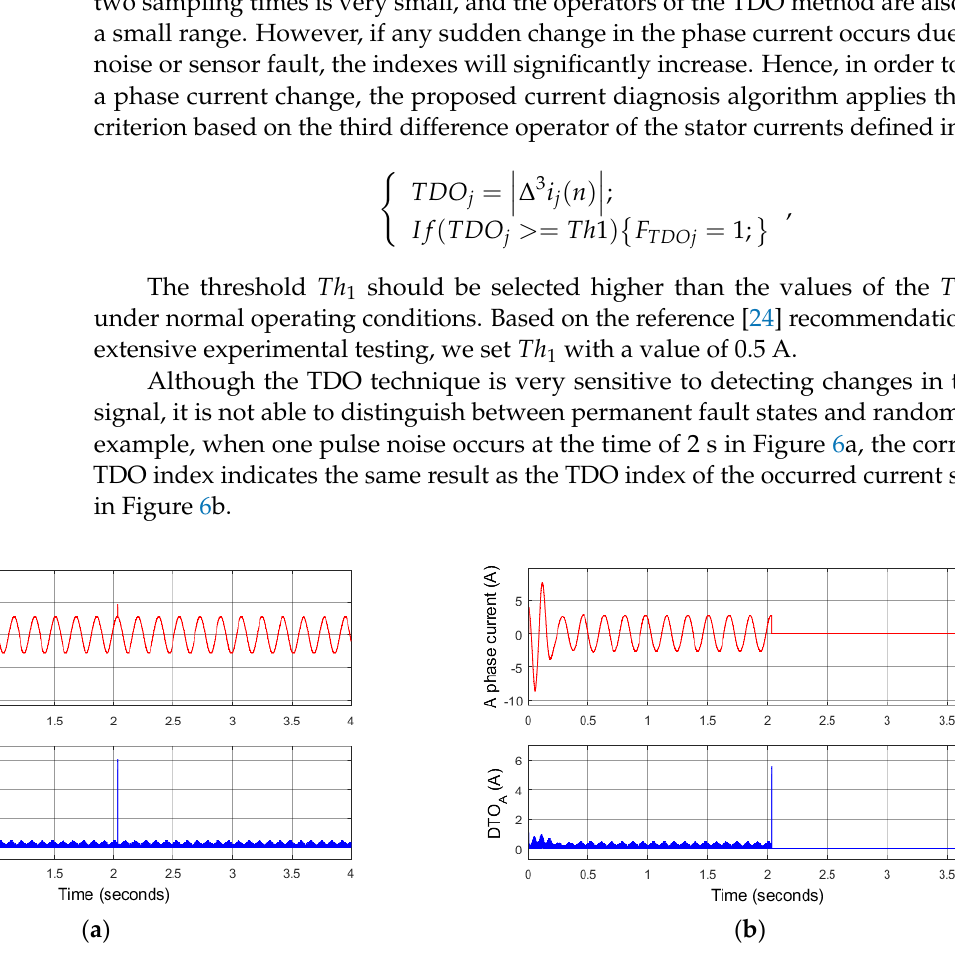
Figure 6. Simulation results: changes of TDO indexes in cases: ( a ) random noise of A phase current signal; ( b ) total fault of A phase current sensor.